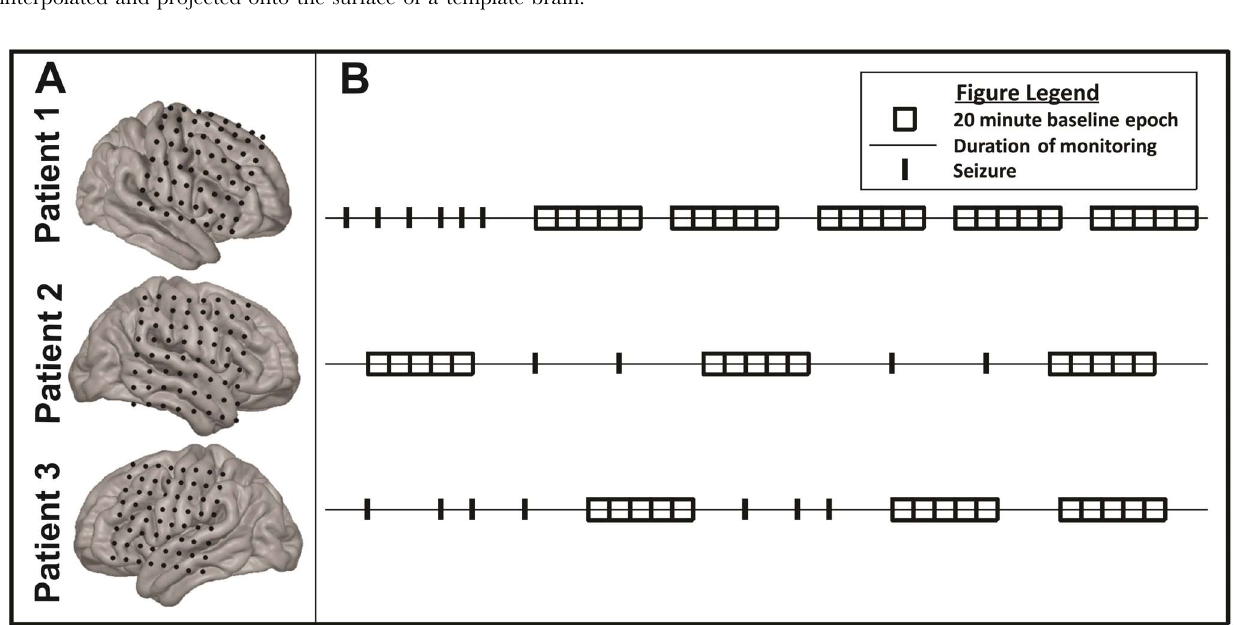
Figure 1. Patient Data. (A) Patient specific electrode grid coverage. (B) Graphical representation of ECoG interictal and ictal epochs selected for analysis. doi:10.1371/journal.pone.0107401.g001 PLOS ONE |